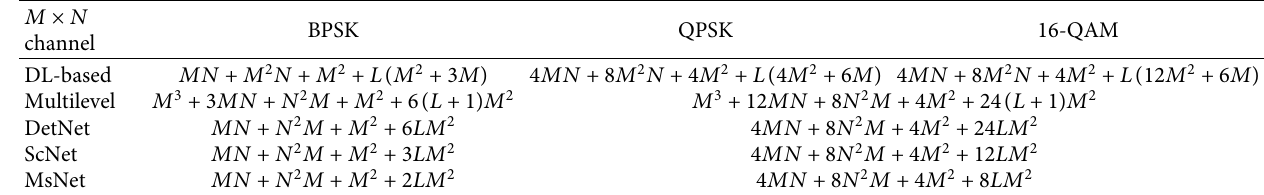
Table 2: Comparison of different network complexities.